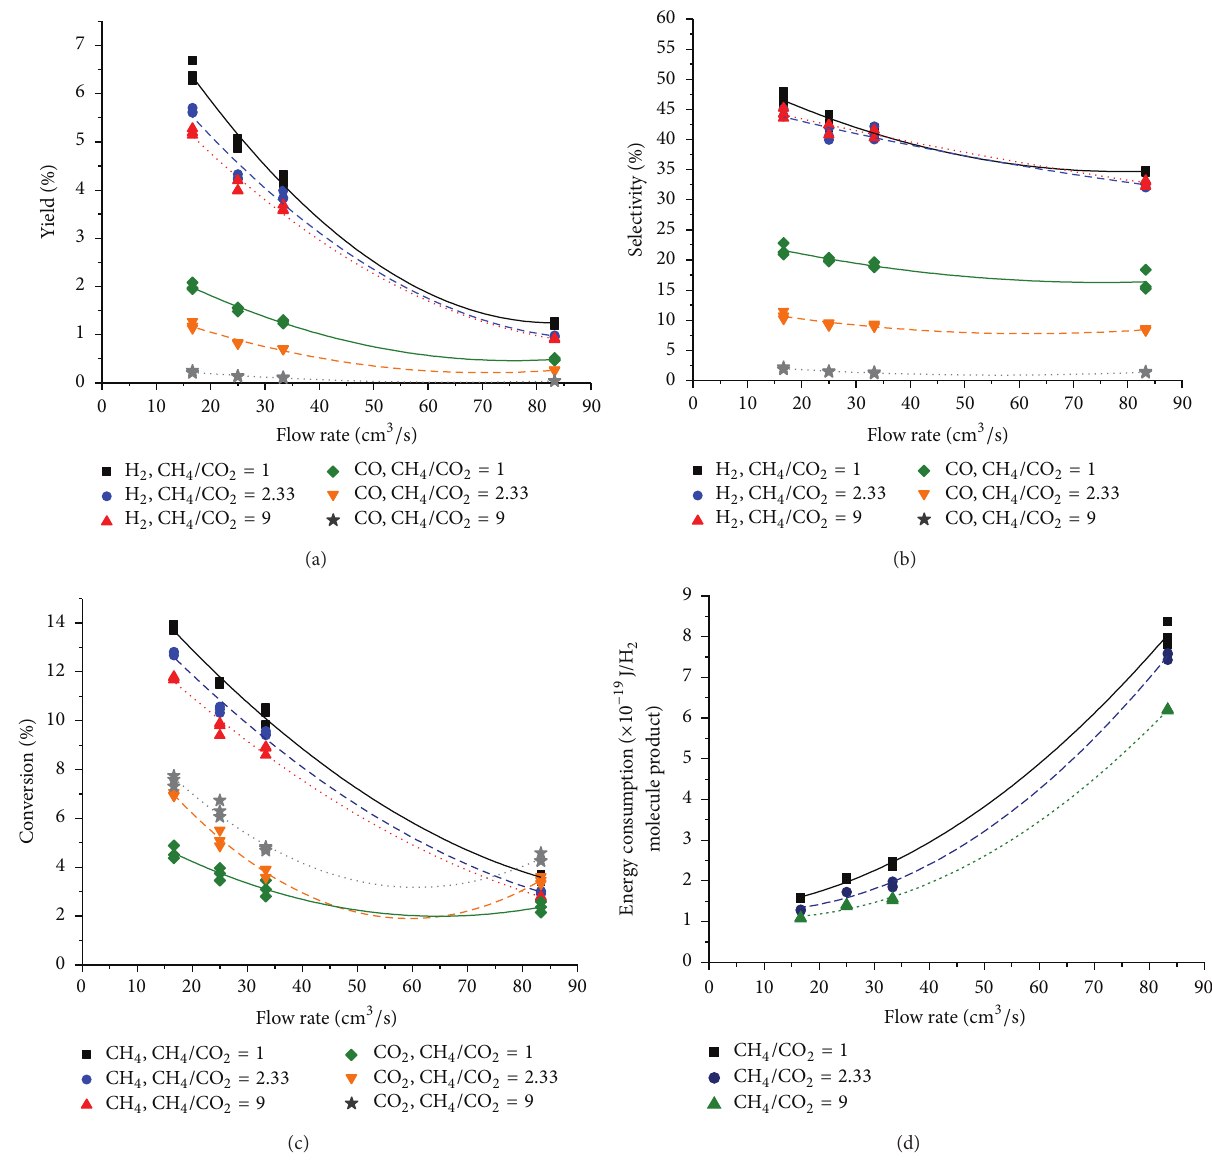
Figure 3: Effect of flow rate on biogas reforming